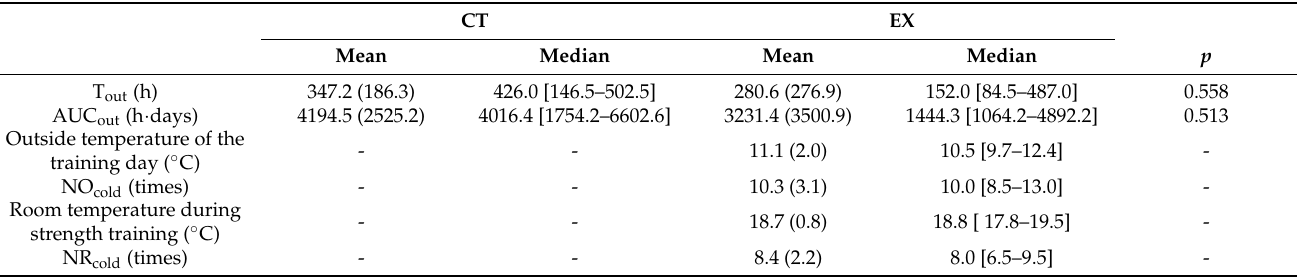
tion in the control group (CT) and the exercise group (Ex). The circle and diamond plots indicate individual values and the mean values, respectively.